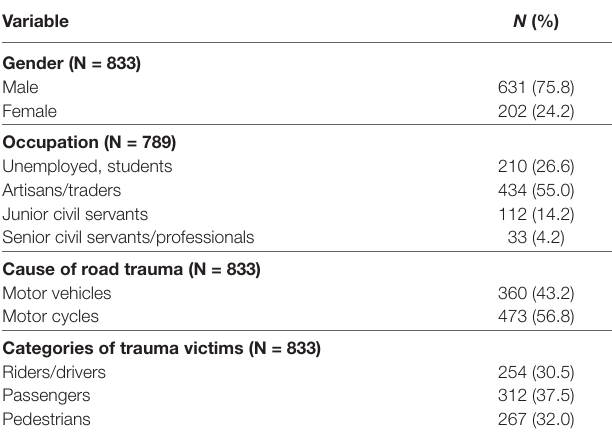
Table 1 | Road-traffic injury-related head injury from Nigeria: characteristics of the study subjects.